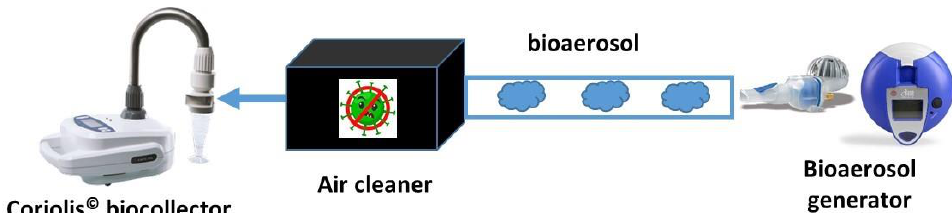
Figure 3. Schematic representation of the experimental setup for the evaluation of the virucidal ac- activity of the APR tivity of the APR technology.